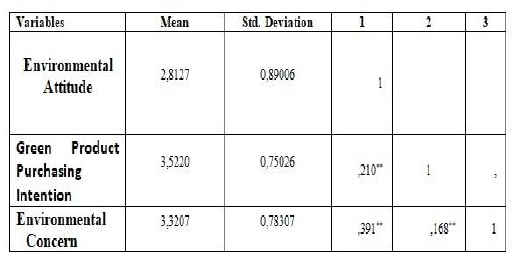
Table 3. Means, Standard Deviations and Correlation Values for the Variables